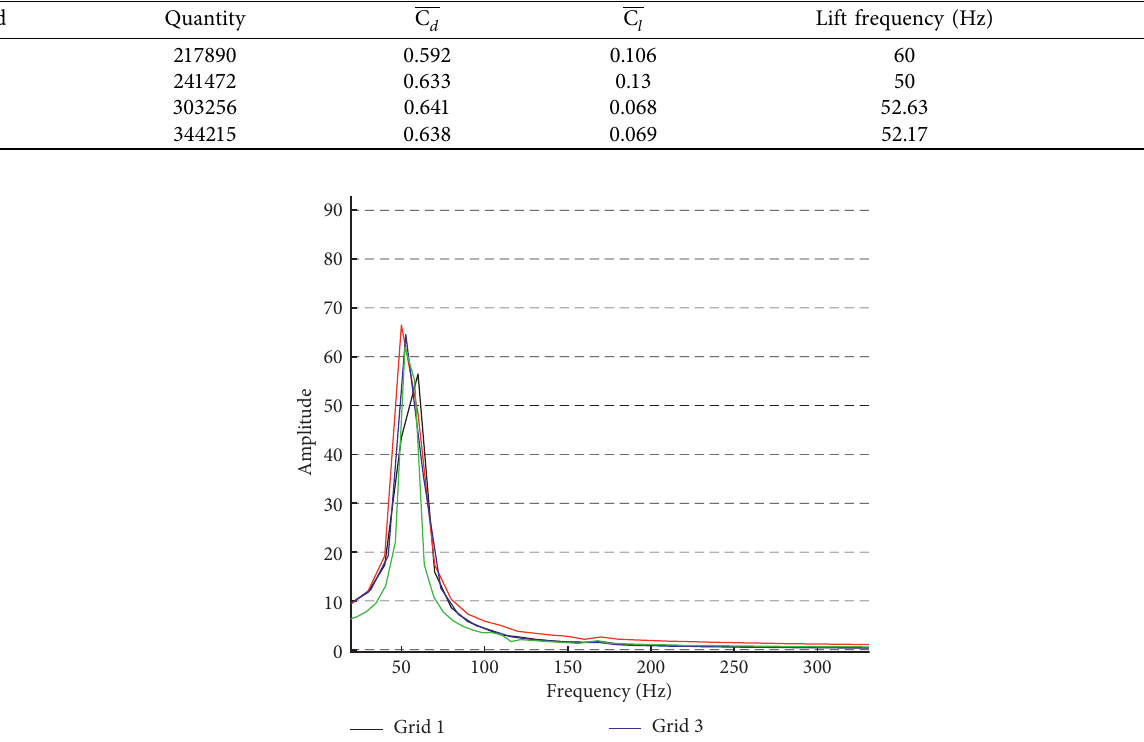
Table 8: Grid independence results of five-tube bundle.